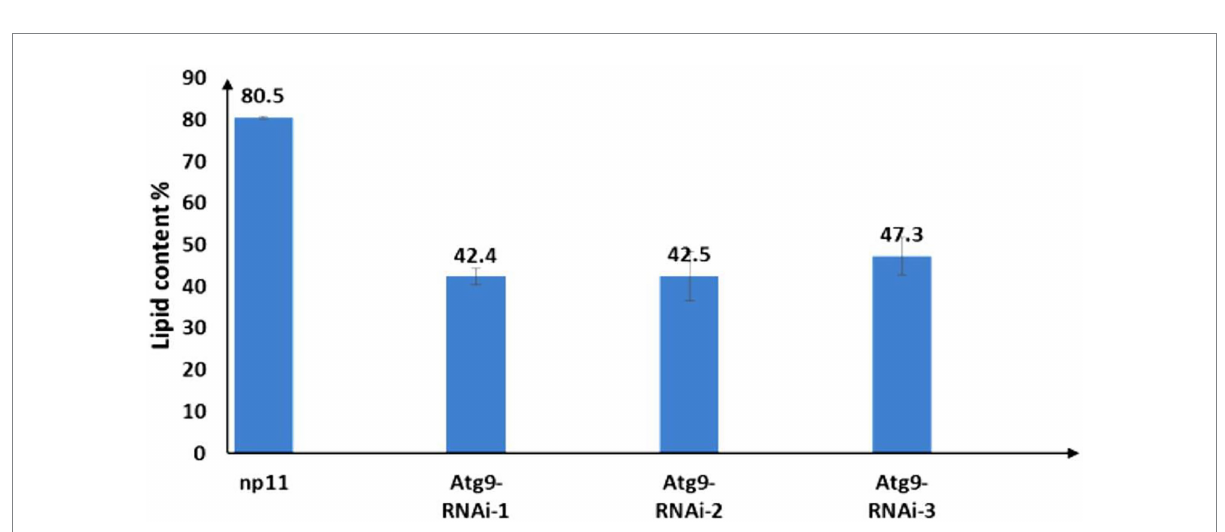
FIGURE 6 Lipid content of R . toruloides WT and ATG 9 RNAi silencing cells under phosphorus limitation